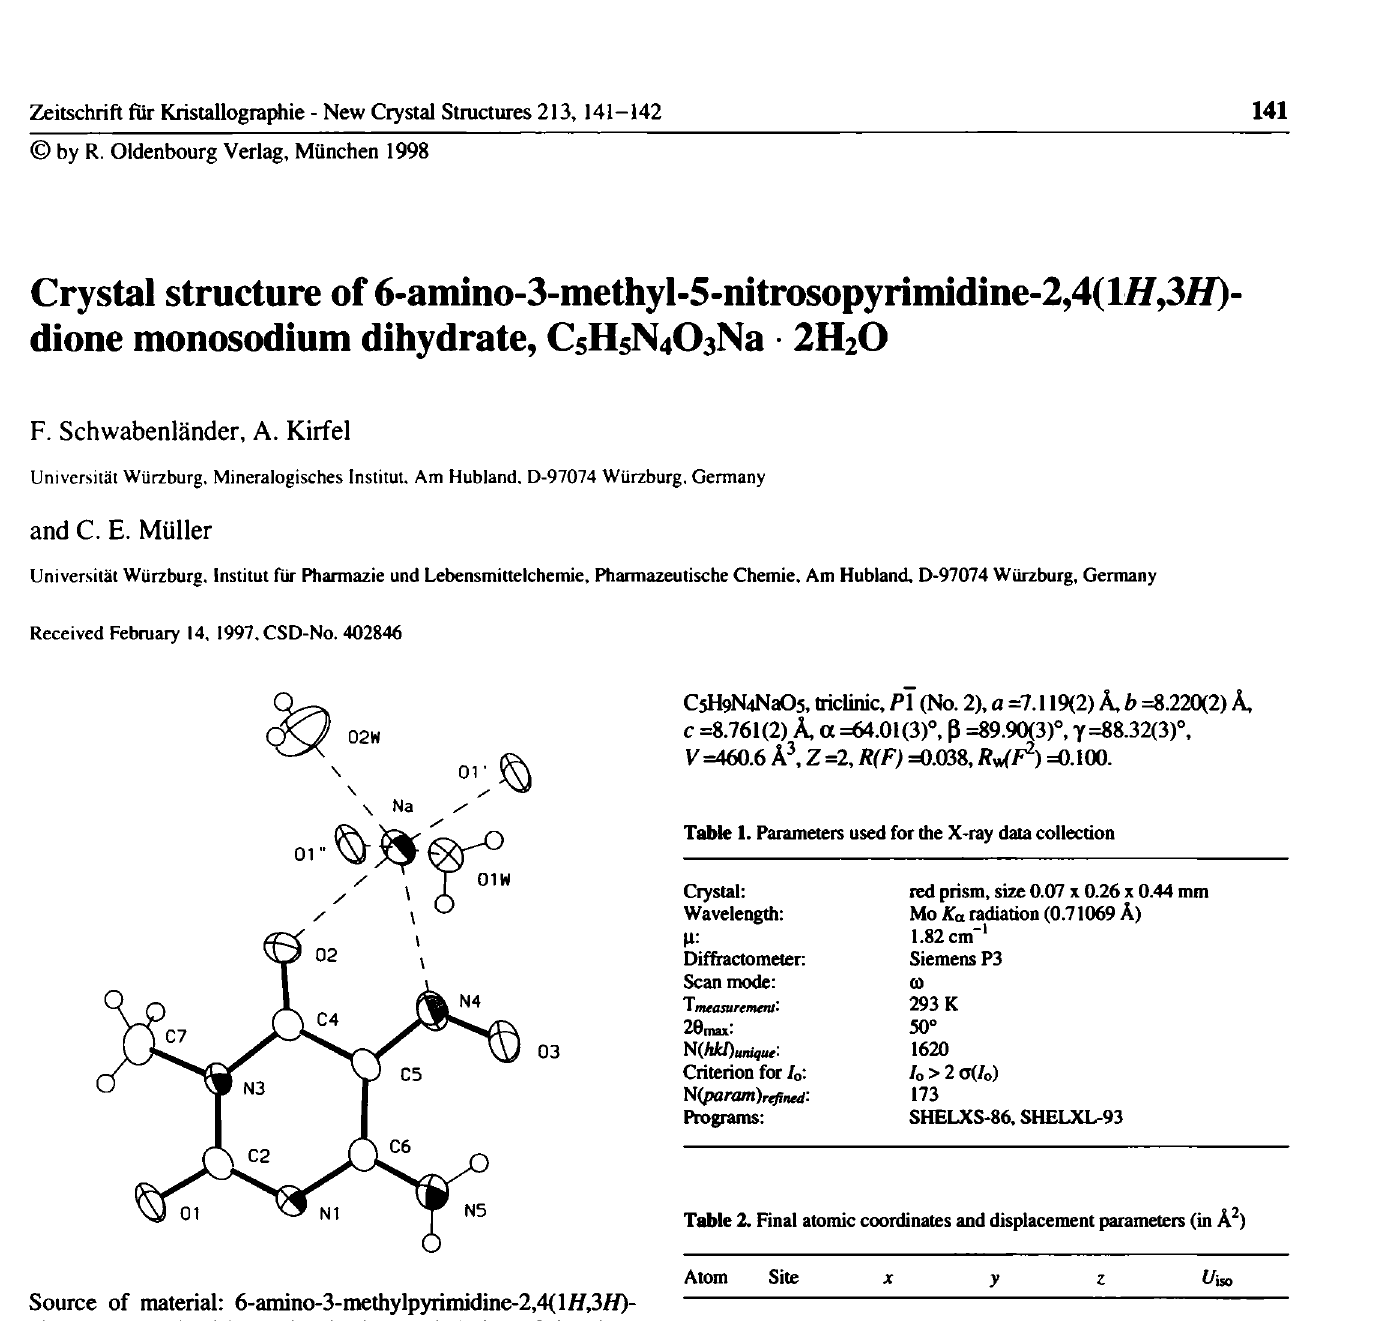
Table 2. Final atomic coordinates and displacement parameters (in Â^)